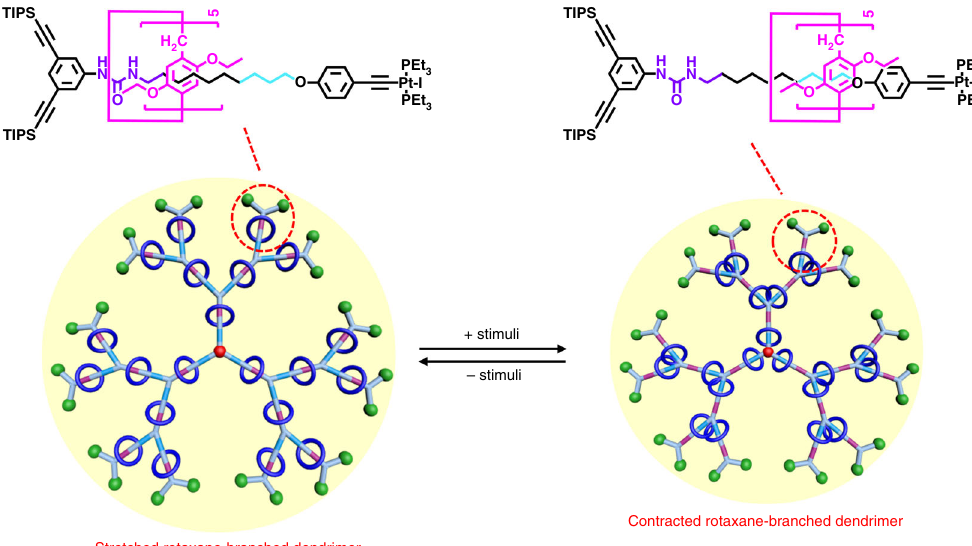
Fig. 1 Cartoon representation of the dimensional modulation of rotaxane-branched dendrimer upon the addition or removal of external